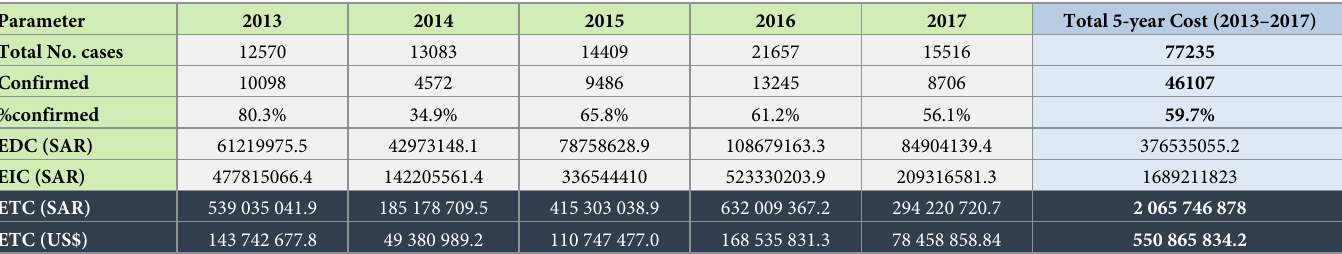
Table 7. Estimated dengue costs in Saudi Arabia during the period 2013–2017 including the correction for under-reporting.